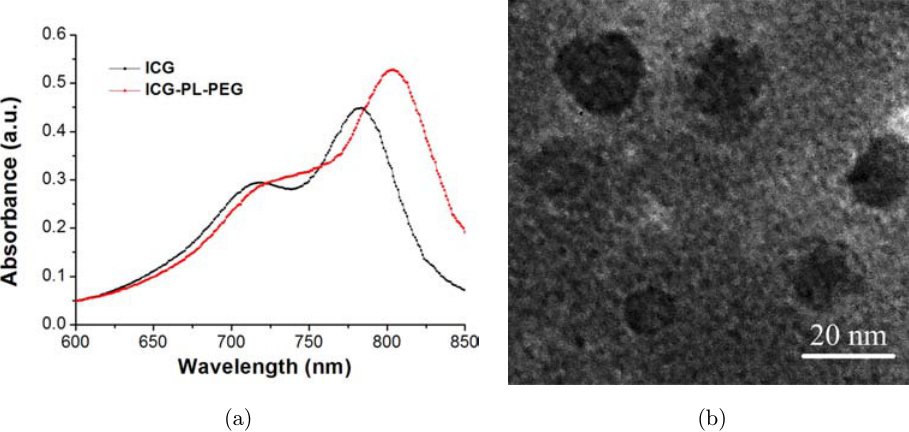
Fig. 1. (a) Absorption spectra of ICG and ICG (cid:1) PL (cid:1) PEG nanoparticles, respectively. (b) TEM imaging of ICG (cid:1) PL (cid:1) PEG